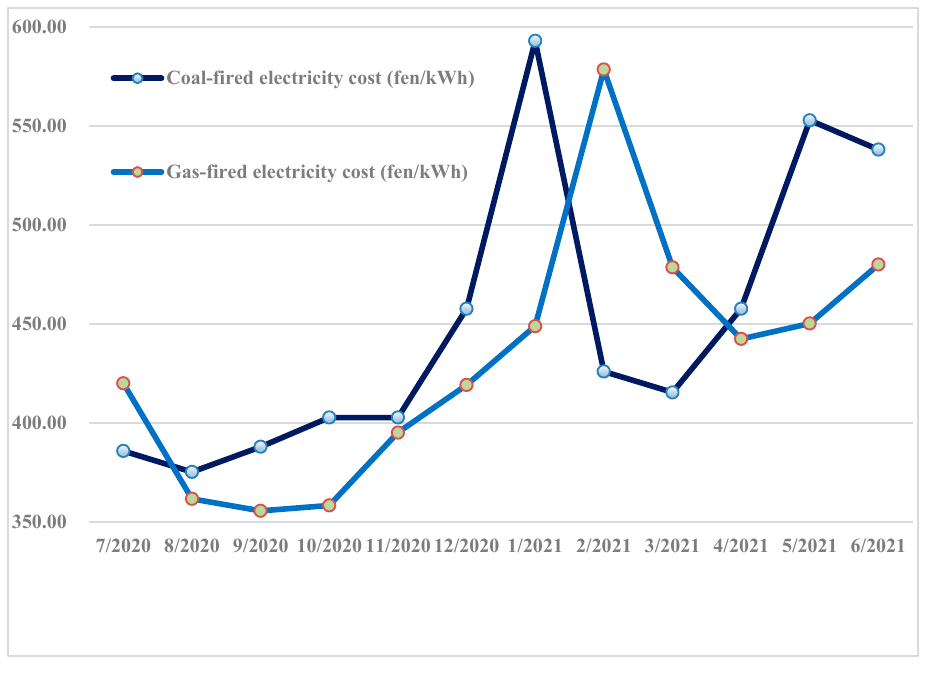
Figure 5. July 2020–June 2021 Trends in power generation costs of coal-fired and gas-fired power generation groups.